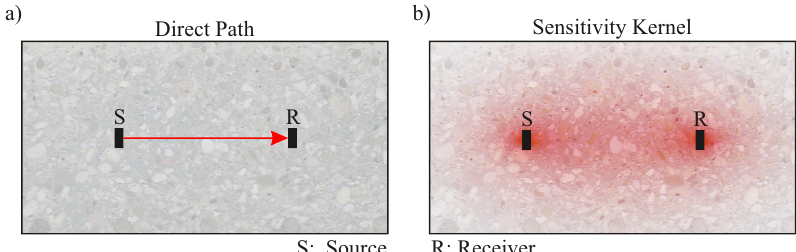
Figure 3. In classical ultrasonic (US) measurements, travel times are recorded and calculated via the ballistic waves. ( a ) Ballistic wave between source and receiver. Using coda waves, changes of travel time within a larger segment, described by ( b ) the sensitivity kernel (red), can be resolved.